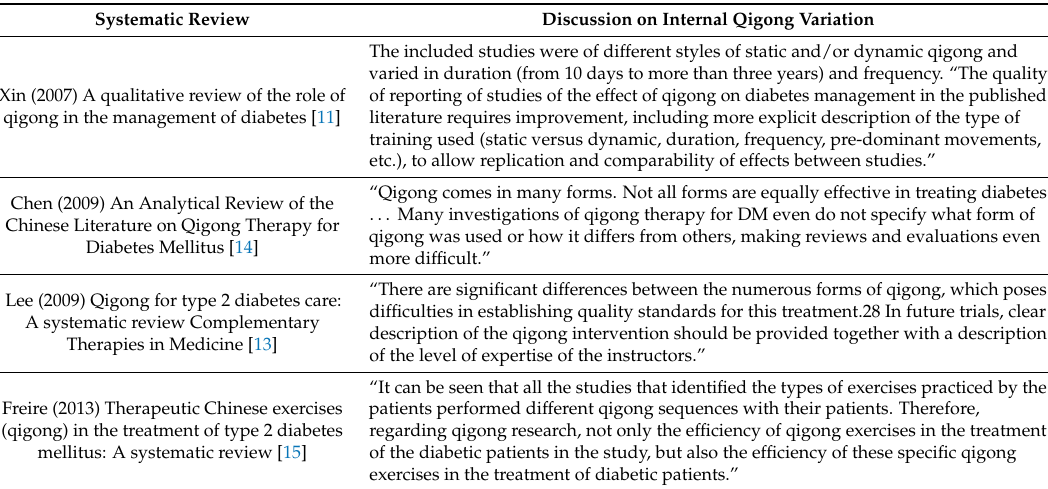
Table 1. Summary of definitions for internal qigong in systematic